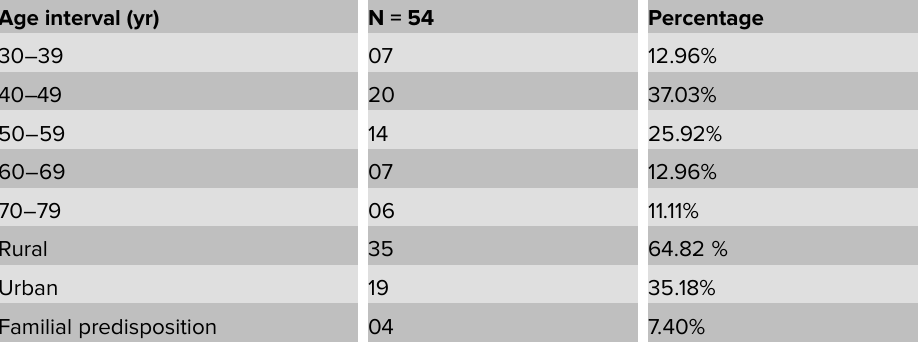
Table 1: Demographics of breast carcinoma patients.